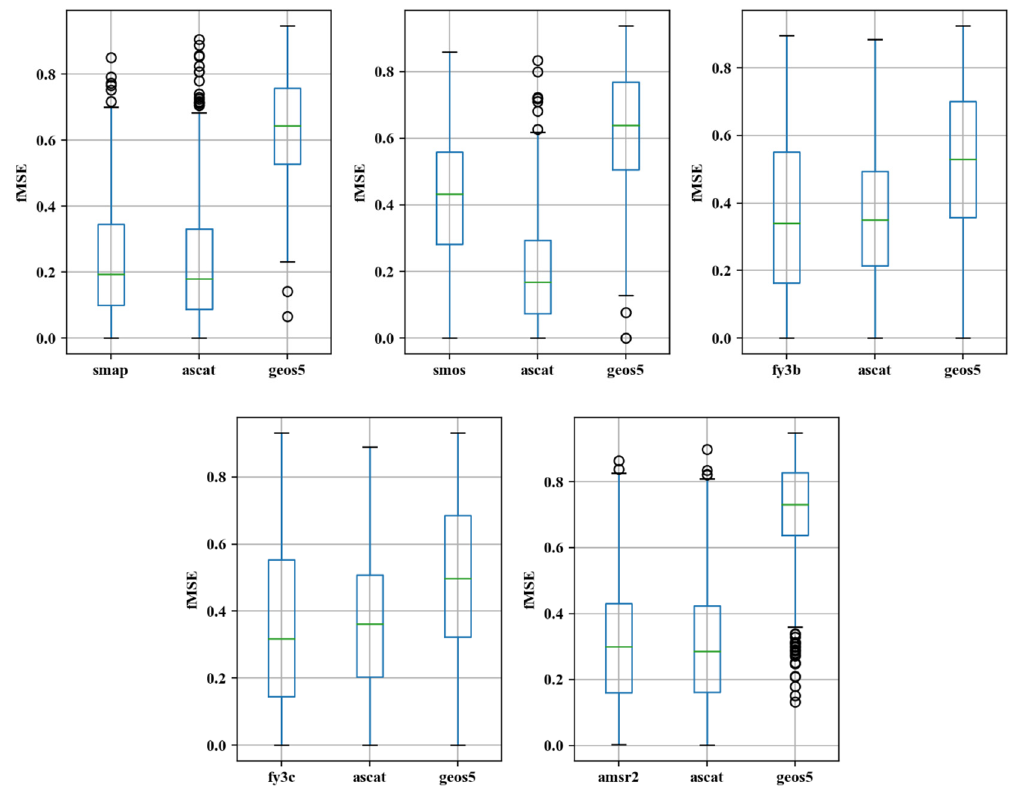
Figure 7. Tail box figures of fMSE in the study area.